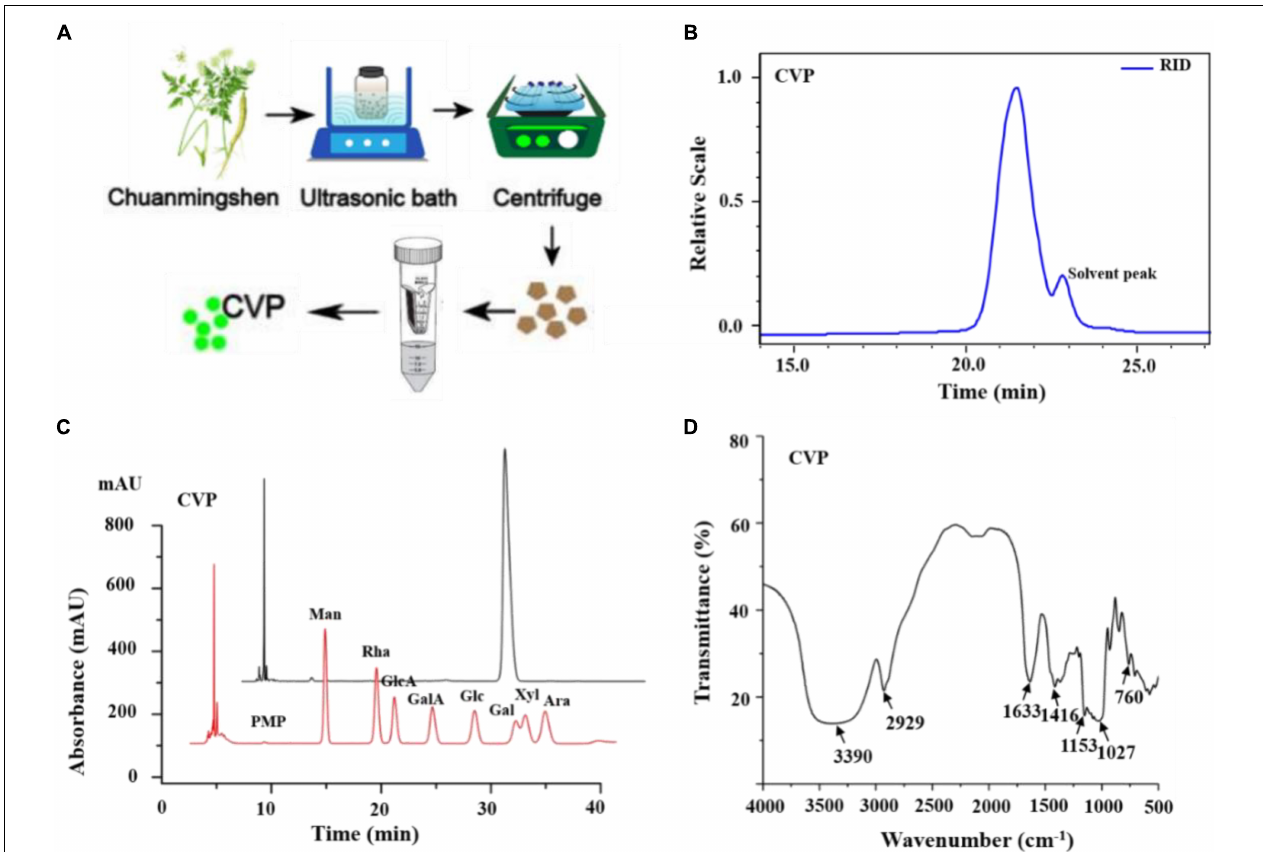
FIGURE 1 | The preparation of Chuanminshen violaceumis polysaccharide (CVP) (A) ; determination of CVP’s molecular weight (B) ; the monosaccharide compositions of CVP (C) ; and IR spectra (D) .